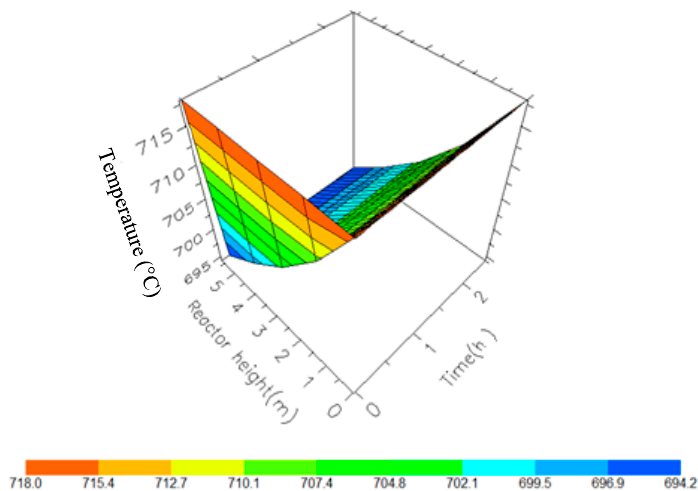
Processes 2019 , 7 , x FOR PEER REVIEW Figure 10. A 3D representation of Reactor 1 Temperature variation with reactor height and time.